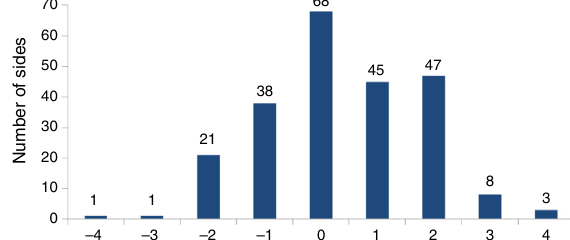
The distribution of the number of the 2 mm-thick slices between the coronal plane of the posterior wall of the maxillary sinus and the sphenoid ostium. A sphenoid ostium anterior to the coronal plane of the most posterior point of the posterior wall of the maxillary sinus was given a negative value. provides a reasonable margin of safety from the skull base and the sphenoid sinus can be entered safely without dam- age to the skull base at the height of the highest MMSR. Lastly, attempting to enter the sphenoid too inferiorly rel- ative to the MMSR can be difficult due to thicker bone of sphenoclival junction. the cadaver heads sagittally in the midline and endoscopic